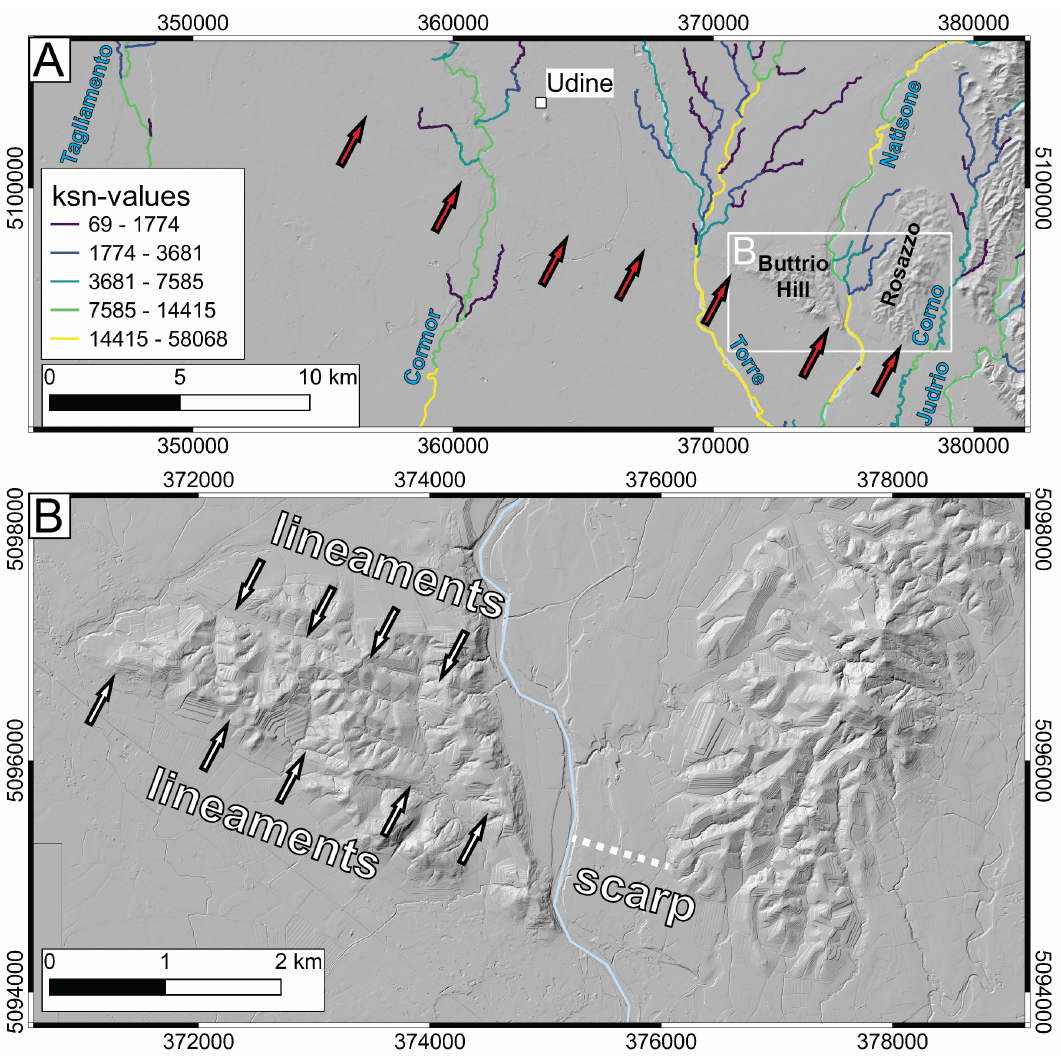
Figure 5. ( A ): Normalized steepness index ( k sn ) map of the main rivers and their tributaries in the study area. The red arrows indicate the fault as in Figure 3. Note the logarithmic scale of the k sn -values. Although the fault clearly offsets the LGM deposits, the k sn -values do not change systematically from the hanging wall to the footwall. This is probably due to the low rate of tectonic deformation and the dynamic river system. Hillshade is from the 10 m TINITALY DEM. ( B ): Close-up view of the area marked in ( A ). Lineaments in the Buttrio Hill are parallel to the scarp we investigated in detail in the Natisone terrace system. One of the lineaments aligns with the scarp. Note the terracing on the hill that hosts vineyards. Hillshade is from the 1 m LiDAR